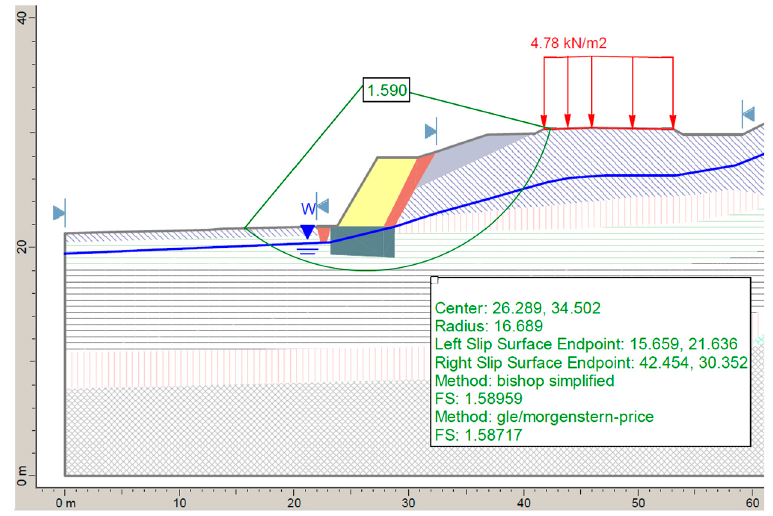
Figure 10. Stability analysis considering the projected wall alone.